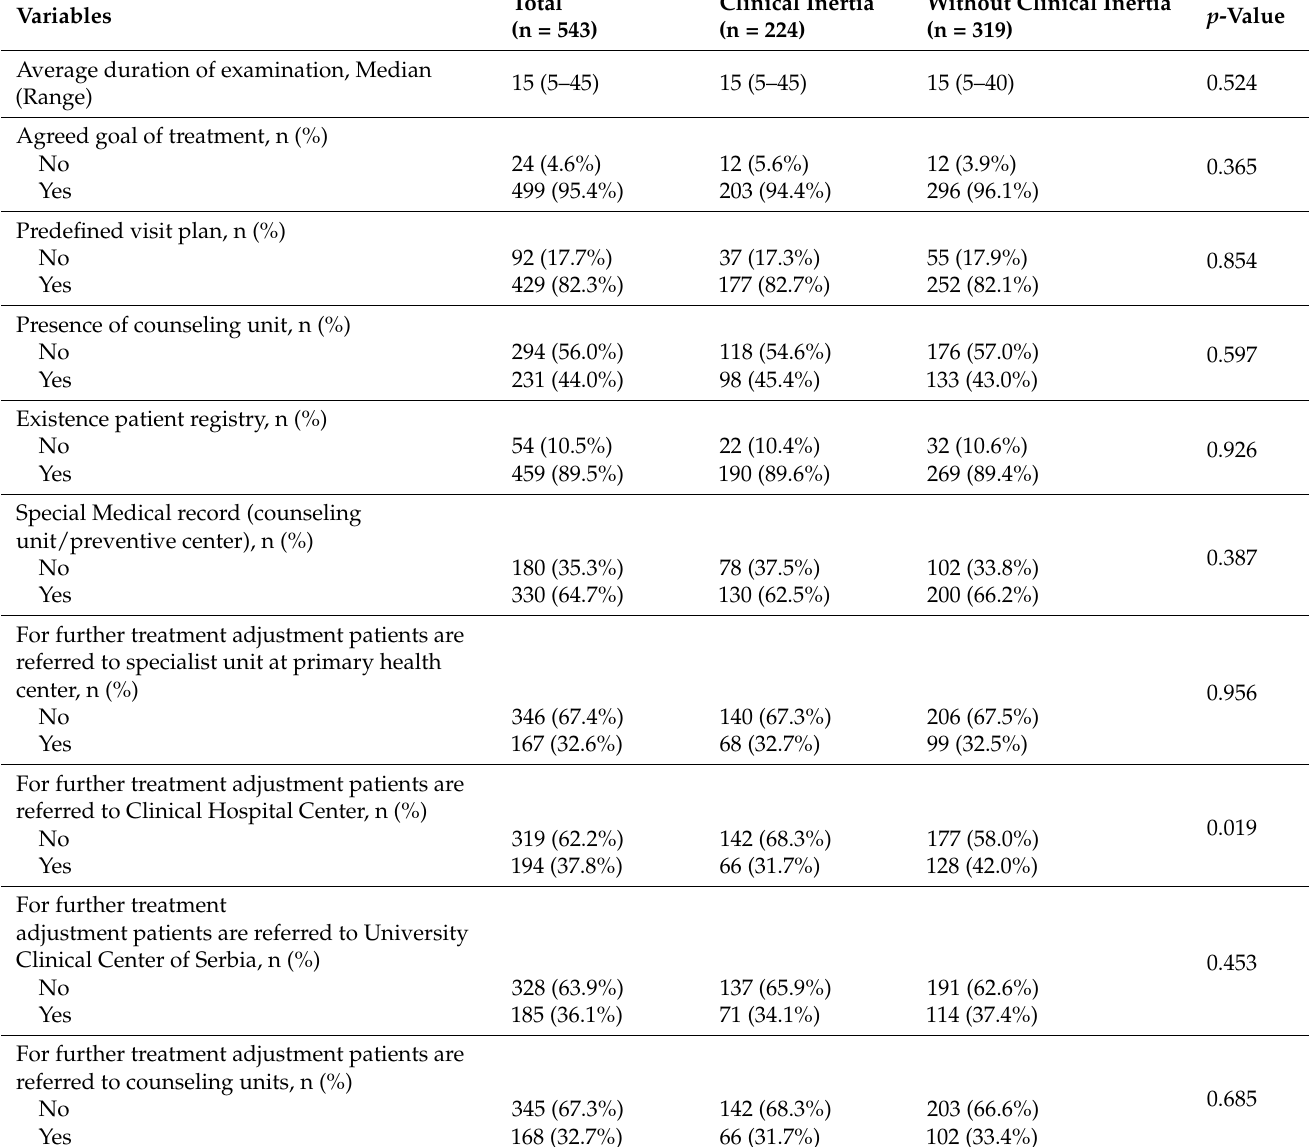
Table 5. Healthcare system related descriptors and clinical